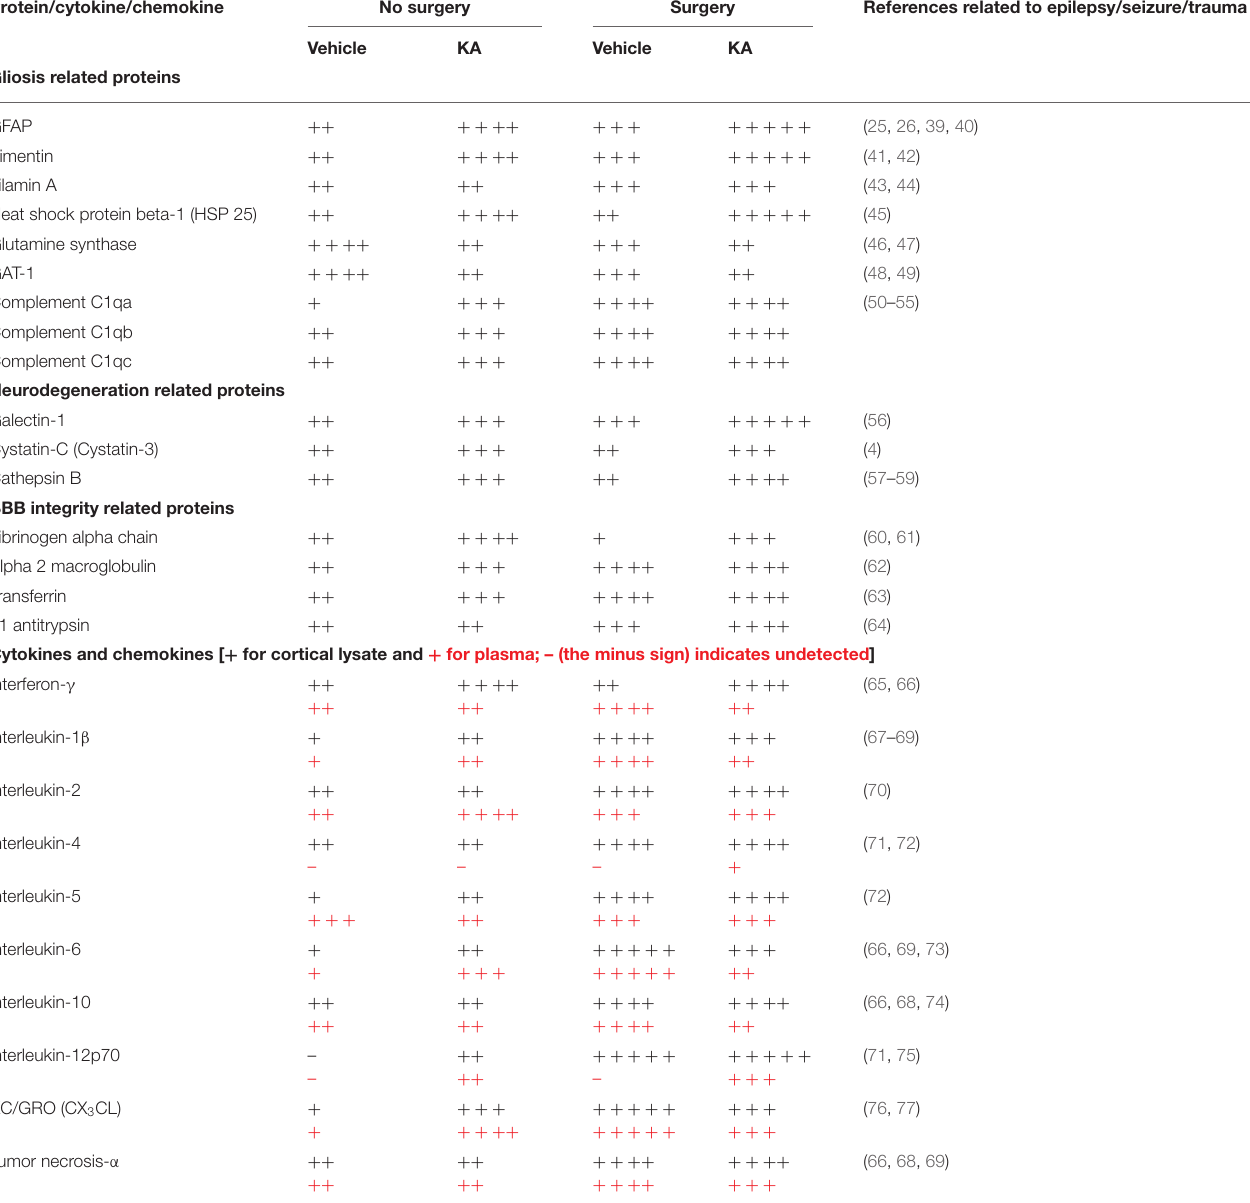
TABLE 6 | Summary of altered hippocampal proteins and cortical and plasma proinflammatory cytokines and chemokines between groups. Protein/cytokine/chemokine No surgery Surgery References related to epilepsy/seizure/trauma Vehicle KA Vehicle